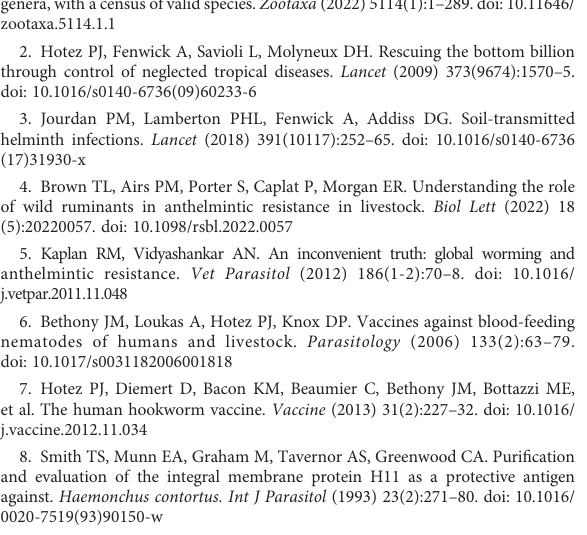
SUPPLEMENTARY TABLE 3 N-glycan con fi gurations predicted for native H11 from Haemonchus contortus released by PNGase F. SUPPLEMENTARY TABLE 4 N-glycan con fi gurations predicted for native H11 from Haemonchus contortus released by PNGase A.